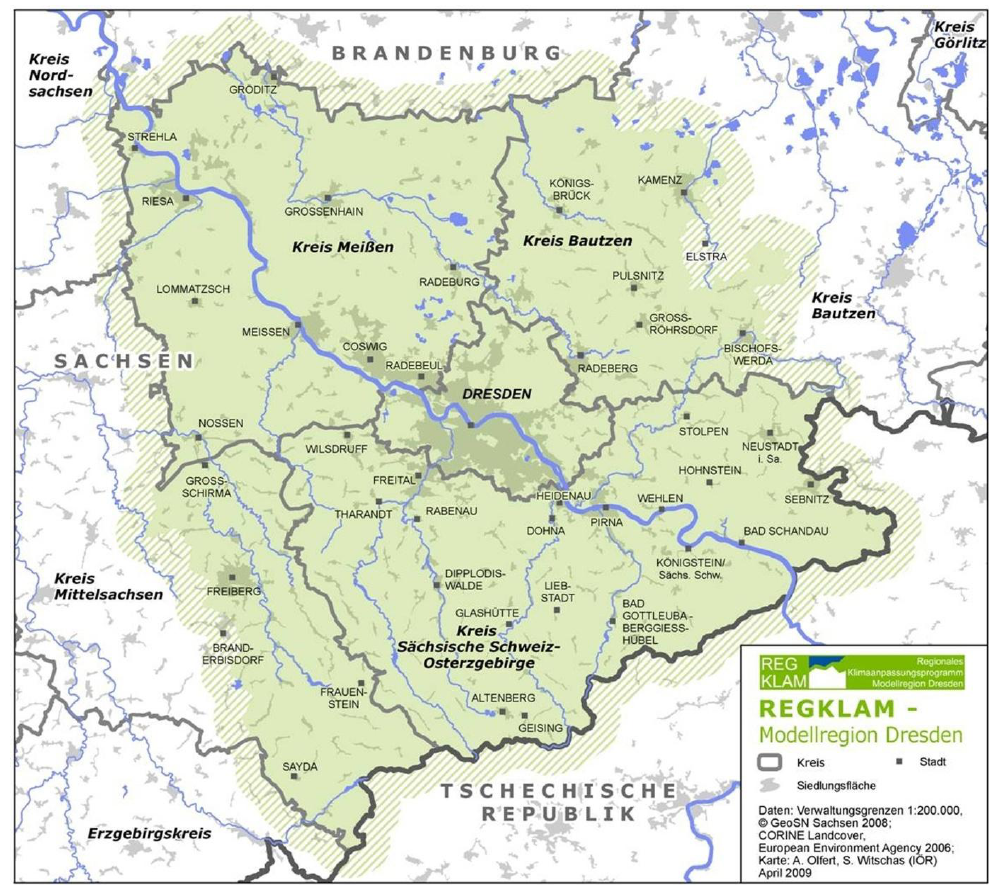
Fig. 1. The Dresden region as defined in the REGKLAM project network. The region is an approximation of the planning region relevant to the KLIMA fit project network (source: Roessler et al., 2013, p. 127)